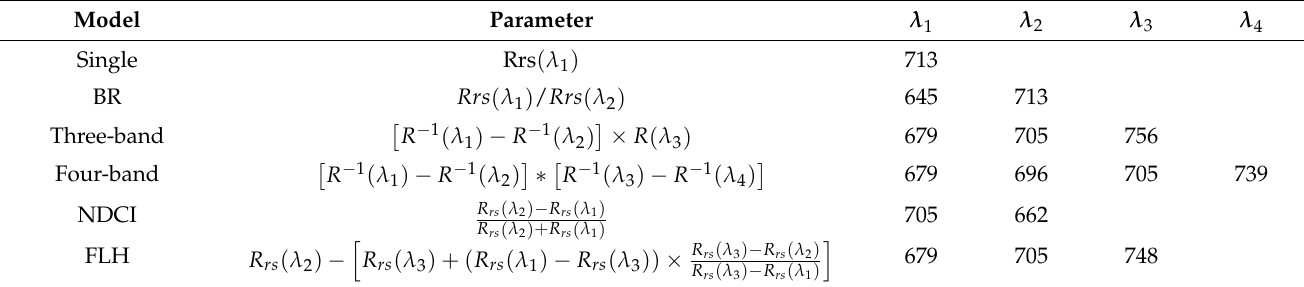
Figure 7. The height of the chlorophyll-a fluorescence peak above the connecting line on both sides. Based on the spectral curve characteristics of the water in Baiyangdian Lake and the spectral channel of ZY1-02D, λ max = 705 nm, λ 1 = 679 nm, and λ 2 = 748 nm. According to the above ZY1-02D sensitive band screening, Table 2 was obtained. Table 2. ZY1-02D sensitive